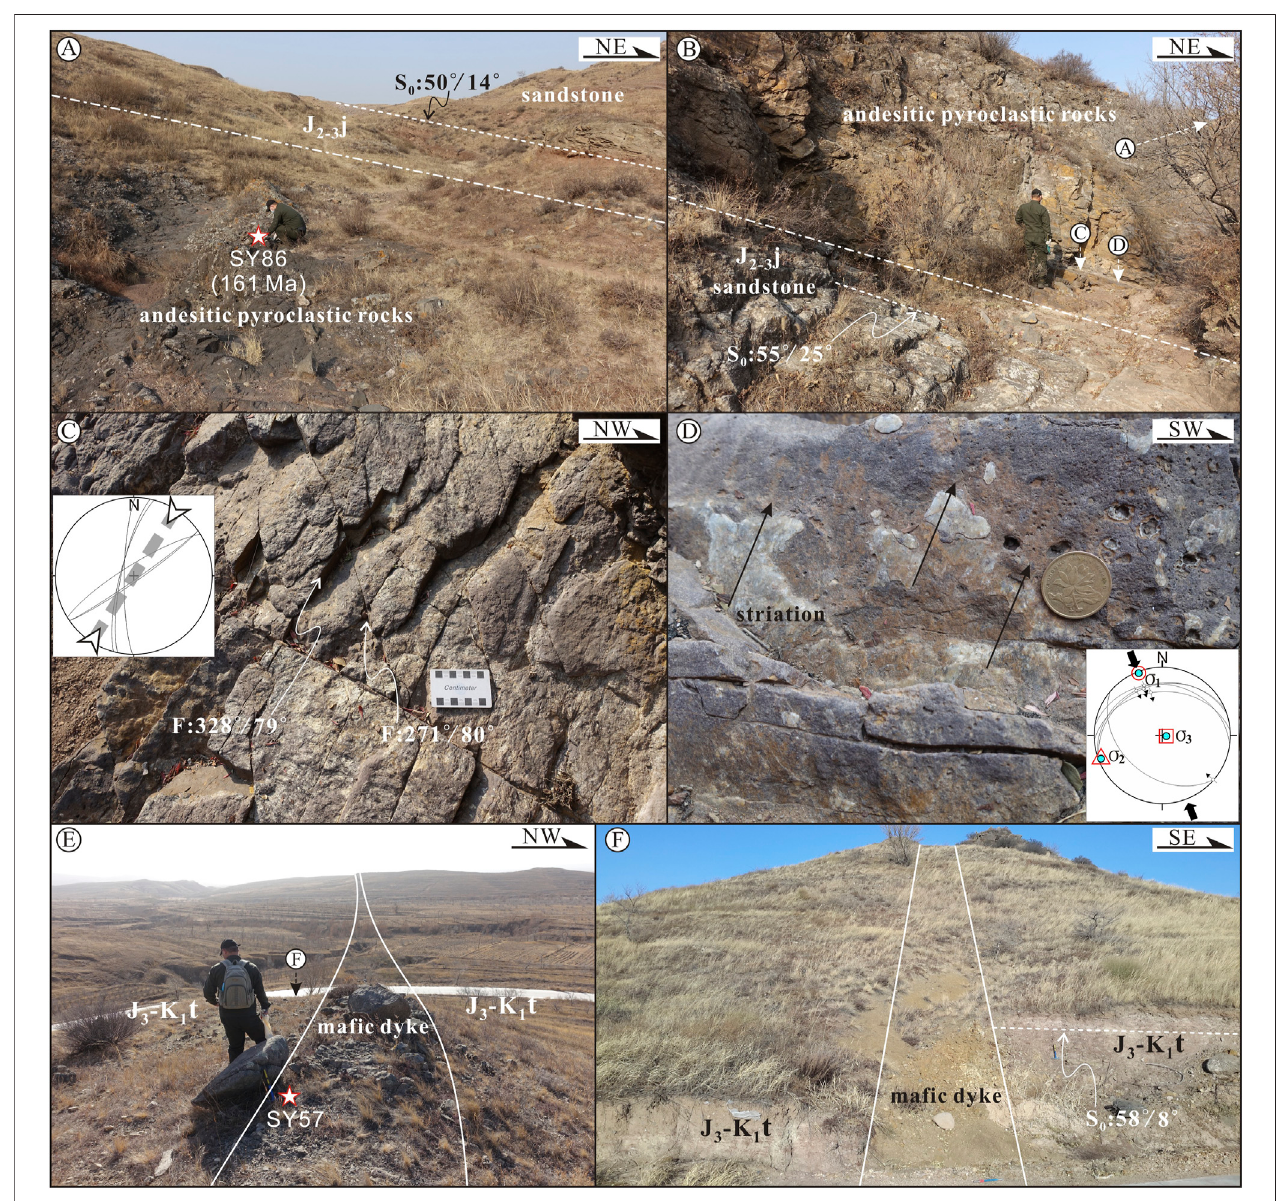
FIGURE 11 | Outcrop photographs of zircon U-Pb dating samples from Shangyi area. (A) Sample SY86 was collected from a pyroclastic interlayer within the sandstones of the Jiulongshan Formation near the Beicaonian in the west edge of the basin. The interlayer, along with surrounding strata, is gently inclined to the northeast. (B) The conformable contact between the pyroclastic interlayer and underlying sandstones. (C) The X-type conjugate shear fractures resulted from NE-SW compression are exposed on the pyroclastic rocks. (D) Fault striations associated with NW-SE compression are developed in the pyroclastic rocks. (E) Sample SY57 was acquired from a NE-trending ma fi c dike intruded into the sandstones (Tuchengzi Formation) at the north of Jiashihe. (F) The near-upright ma fi c dike is embedded in the subhorizontal Tuchengzi Formation sandstones. Lower hemisphere, equal-area projections.